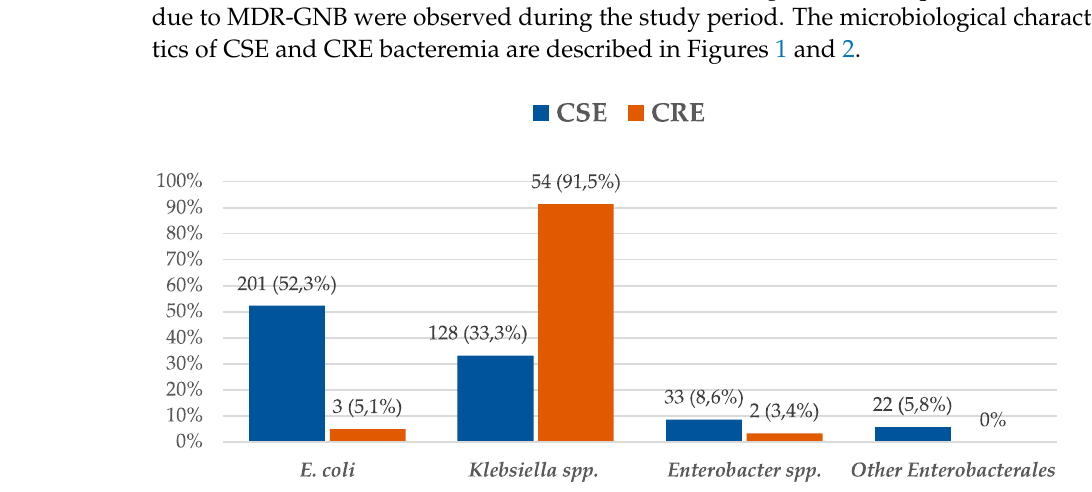
Figure 2. Resistance mechanisms of Enterobacterales. Proportion of extended ‐ spectrum β‐ lactamases (ESBL) and Amp ‐ C producers in carbapenem ‐ susceptible Enterobacterales (CSE) isolates. Proportion of bla KPC and bla OXA ‐ 48 in carbapenem ‐ resistant Enterobacterales (CRE) isolates. Two hundred and ninety ‐ six (66.8%) of the bacteremia cases were classified as nosocomial infections, and the length of hospitalization until bacteremia was 9 days (interquartile range (IQR): 0–15). Three hundred and twenty (72.2%) bacteremia cases had a clinical source, with abdominal being the most frequent (129, 29.1%). The empirical antibiotic treatment (EAT) was adequate in 85.8% of the patients, with monotherapy (321, 72.4%) being the most frequent. One hundred and thirteen patients (25.5%) developed shock, and 34 (7.7%) had breakthrough bacteremia. The 7 ‐ day and 30 ‐ day mortality was 14.9% and 22.6%, respectively, and was related to infection in more than 70% of the cases. Marked differences were observed in the treatment and outcomes between the two groups, as highlighted in Table 2.